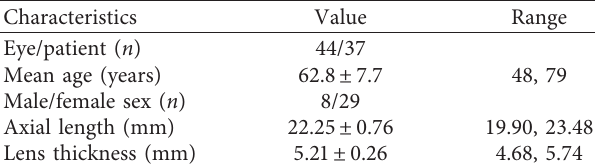
Figure 1: An illustration of the quantitative measurement of the ACD, CLR, AOD500, TIA, and SCPA. (a) ACD: anterior chamber depth; CLR: crystalline lens rise. (b) AOD500: angle opening distance at 500 μ m from a scleral spur; TIA: trabecular-iris angle; SCPA: scleral ciliary process angle. Table 1: Demographic and clinical features of study